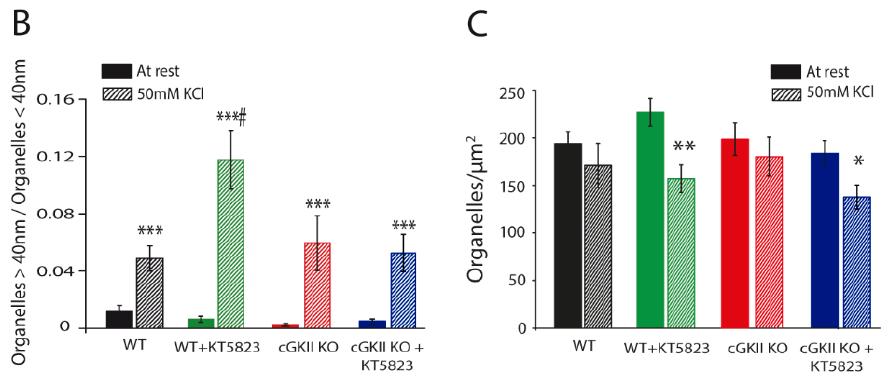
Figure 2. Morphological changes in nerve terminals from WT or cGKII KO cells at rest, or after strong and sustained stimulation. Cells were stimulated (50 mM KCl, 3 min) to mimic FM1-43 loading or maintained at rest. ( A ) Electron micrographs of cerebellar granule cells from WT cells, WT cells treated with KT5823, cGKII KO cells and cGKII KO cells treated with KT5823 at rest or after stimulation. Orange arrows show endosomal structures; ( B ) Ratio of organelles >40 nm/organelles <40 nm at rest or after stimulation: # Represents significant differences respect to the control and * the significance between the basal and stimulated cells in each condition. The data are the mean ( ± SEM) of WT AZs (at rest, n = 30), stimulated WT AZs ( n = 38, *** p = 0.0001, Mann–Whitney), WT + KT AZs at rest ( n = 29), stimulated WT + KT AZs ( n = 34, *** p = 0.0001, # p = 0.014, Mann–Whitney), cGKII KO AZs at rest ( n = 16), stimulated cGKII KO AZs ( n = 14, *** p = 0.0001, Mann–Whitney), cGKII KO + KT at rest ( n = 14), stimulated cGKII KO + KT AZs ( n = 21, *** p = 0.0001, Mann–Whitney); ( C ) Organelle density at synapses. * represents the significance between the basal and stimulated cells in each condition. The data are the mean ( ± SEM) of WT AZs (at rest, n = 30), stimulated WT AZs ( n = 38), WT + KT AZs at rest ( n = 29), stimulated WT + KT AZs ( n = 34, ** p = 0.0012, Mann–Whitney), cGKII KO AZs at rest ( n = 16), stimulated cGKII KO AZs ( n = 14), cGKII KO + KT at rest ( n = 14), stimulated cGKII KO + KT AZs ( n = 21, * p = 0.0222, Mann–Whitney).